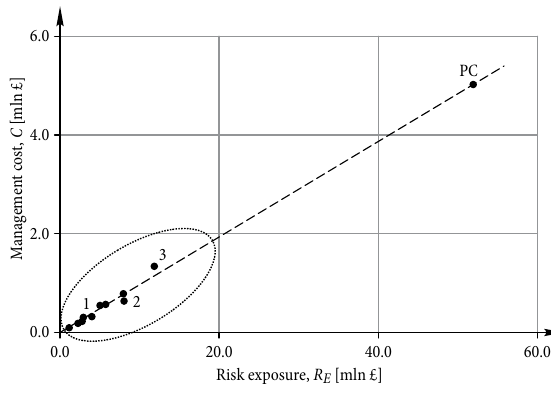
Fig. 5. Exemplar phase portrait